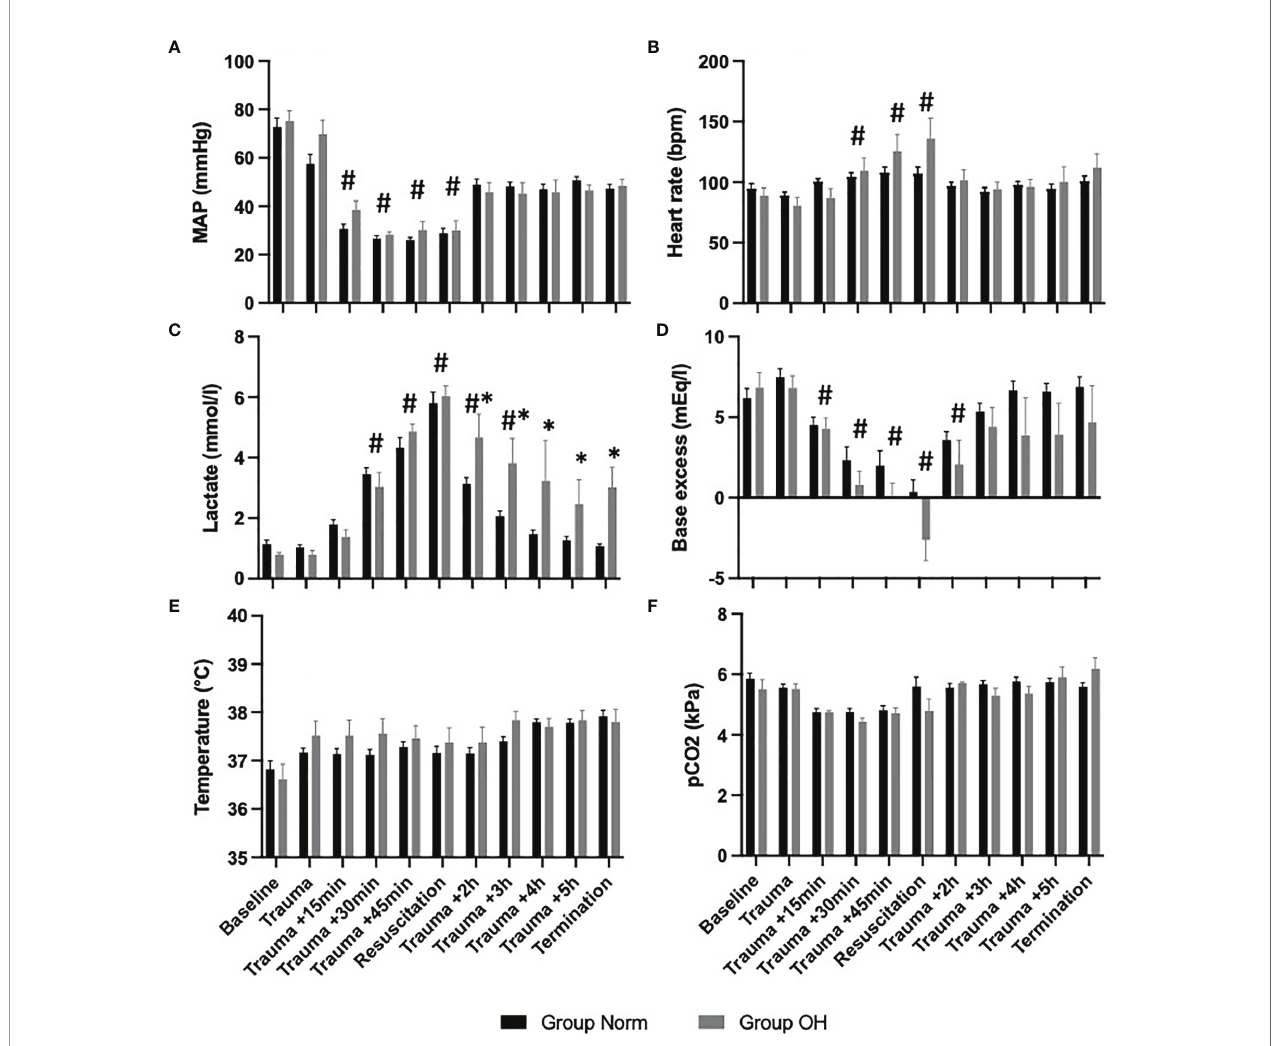
FIGURE 2 | The course of vital parameters, and measures of arterial blood gas analysis during the observational period, presented as mean and standard error of the mean # represents statistical signi fi cant difference to baseline, * represents statistical difference among Group Norm and Group OH at the respected timepoint Statistical signi fi cance after Benjamini-Hochberg adjustment set at p < 005. (A) The course of MAP controlled hemorrhagic shock The MAP decreased signi fi cantly compared with baseline values, however, the MAP remained comparable among both groups. (B) Signi fi cant increase of heart rate (compared with baseline) during hemorrhagic shock and return to comparable values. (C) The lactate value increased signi fi cantly in both Groups when compared to baseline values After the initiation of resuscitation, the lactate value decreased in Group Norm. in Group OH the lactate value remained signi fi cantly higher compared to baseline and to Group Norm. (D) Base excess decreased signi fi cantly in both groups, and remained lower in Group OH (not statistically signi fi cant). (E) The Temperature was comparable during the experiment, and the animals were warmed throughout. (F) The pCO2 level was utilized for ventilation control and remained comparable during the experiment and among both